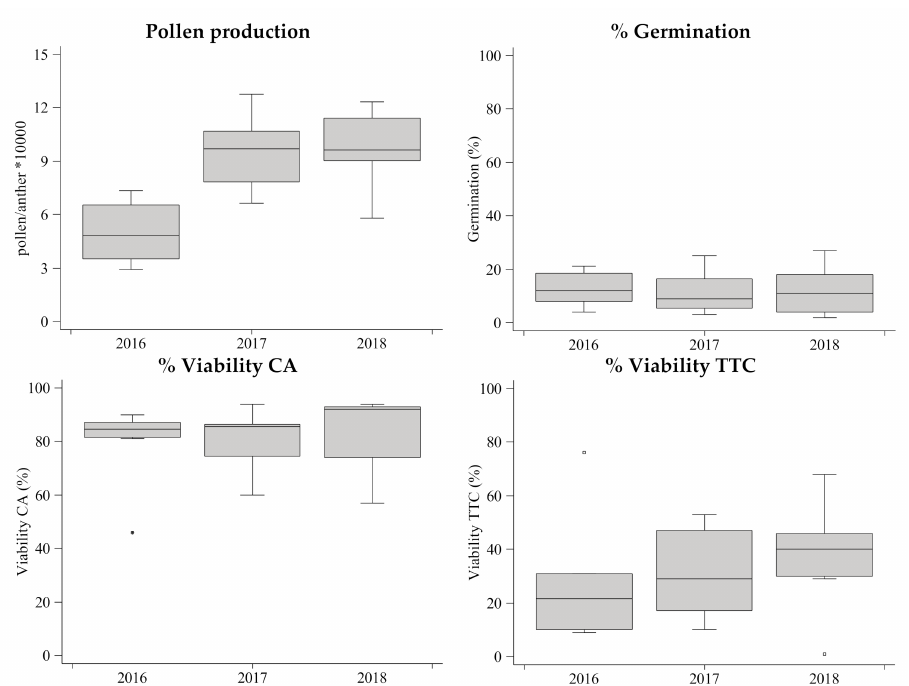
Figure 4. Pollen by anther, % of Germination, % of Viability with carmine acetic (CA) and triphenyltetrazolium (TTC) methods during the studied period. Median (black line), Box: 25–75%, Non-outlier (whisker) and outliers